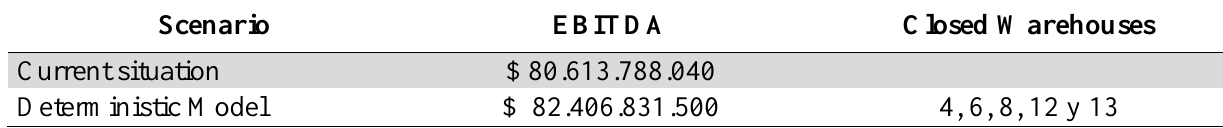
Objective function values (EBITDA) and supply network configuration (Deterministic Model)